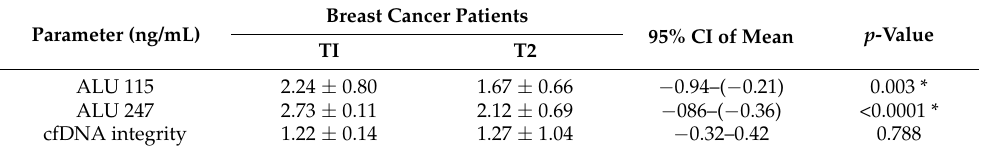
Table 5. Circulating cell-free DNA concentrations and DNA